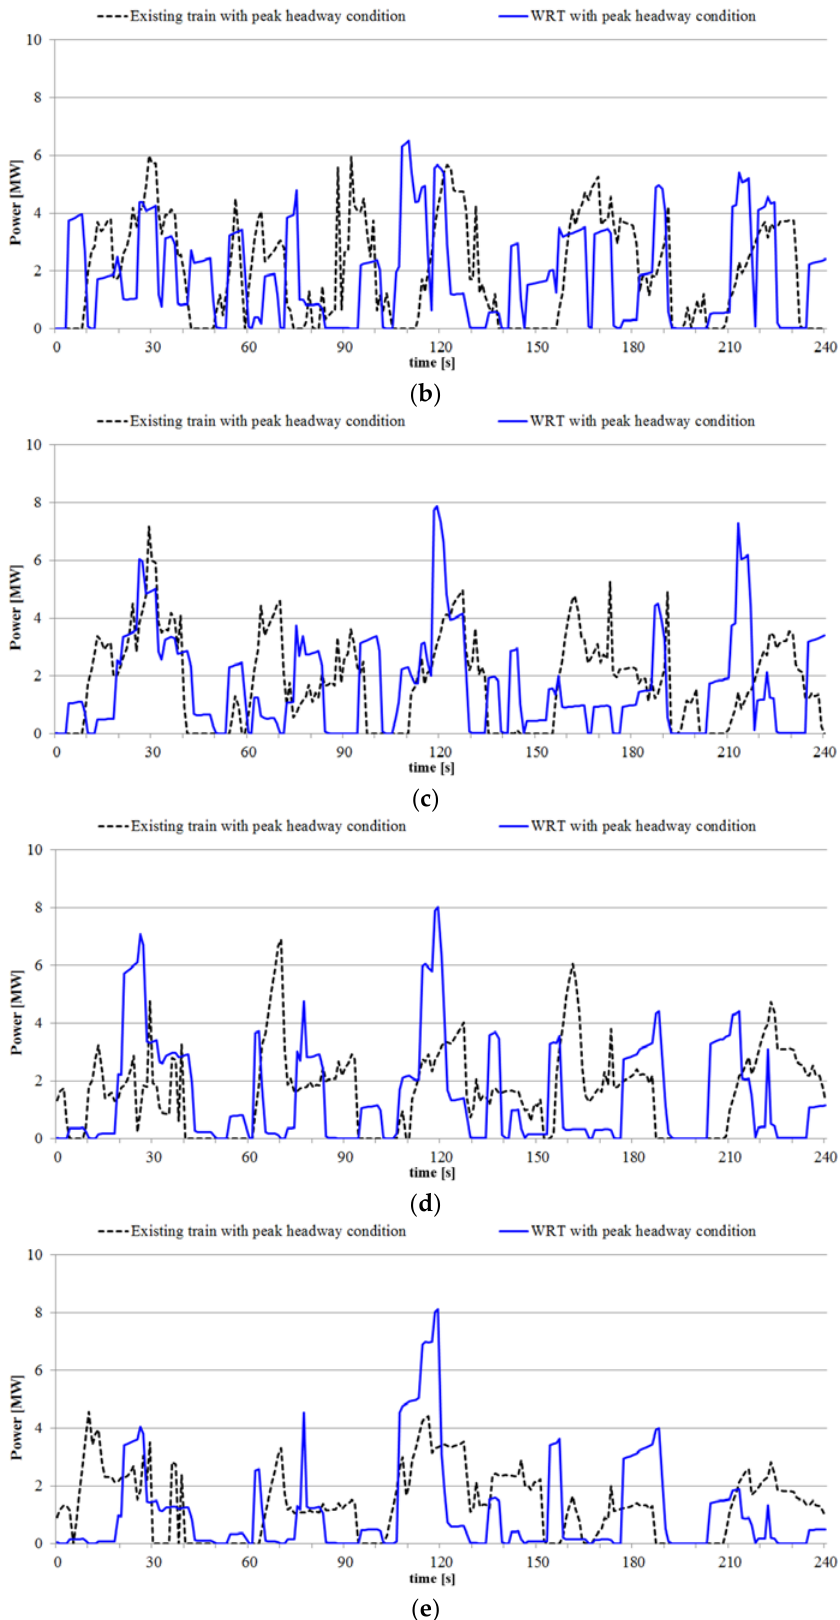
Figure 8. Results of substation power for the peak headway condition. ( a ) Electrical power of Substation 1; ( b ) Electrical power of Substation 2; ( c ) Electrical power of Substation 3; ( d ) Electrical power of Substation 4; ( e ) Electrical power of Substation 5.